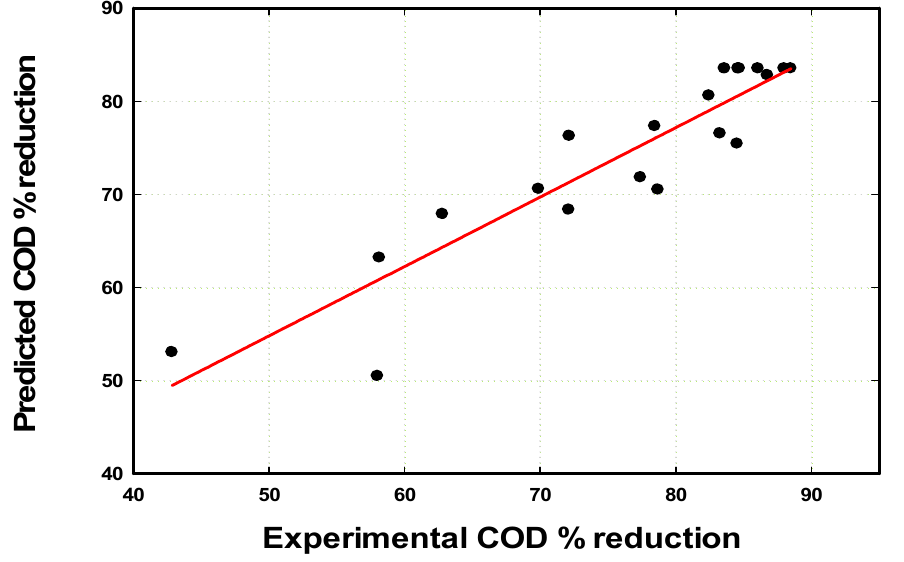
Figure 4. Predicted versus experimental COD reduction values for GTL PW.